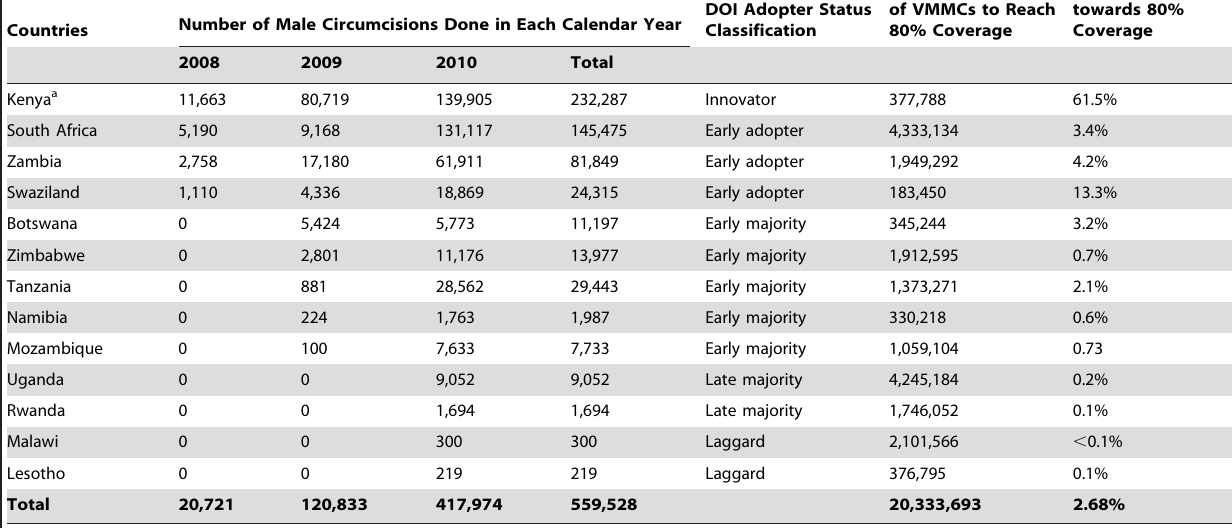
Table 2. Service delivery